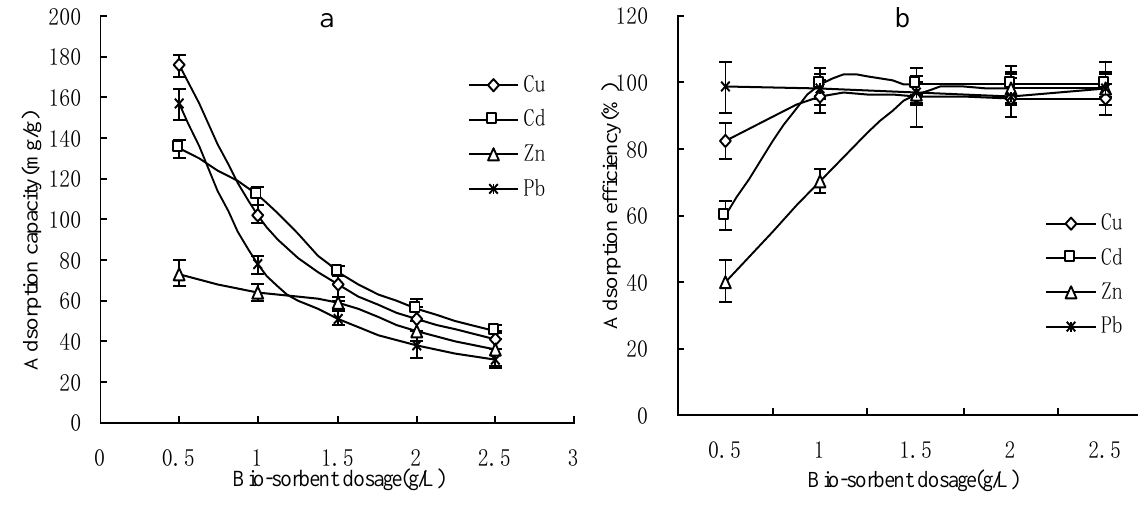
Figure 1. Influence of adsorbent dosage of CCM on the adsorption capacities (a) and removal efficiency (b) of the four heavy metal ions copper (Cu), cadmium (Cd), zinc (Zn), and lead (Pb). Initial metal concentration = 100 ppm; agitation speed = 180 rpm; initial pH = 5.5; temperature = 25 °C; equilibrium time = 2 h).